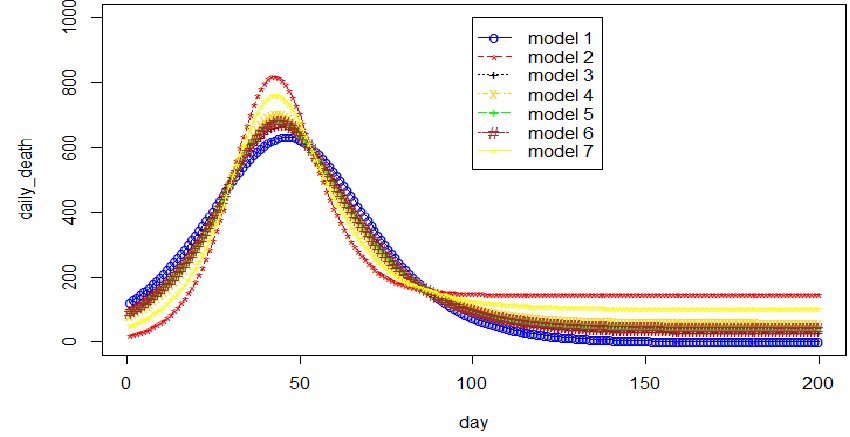
Figure 8. The estimated daily number of deaths vs. day in Italy